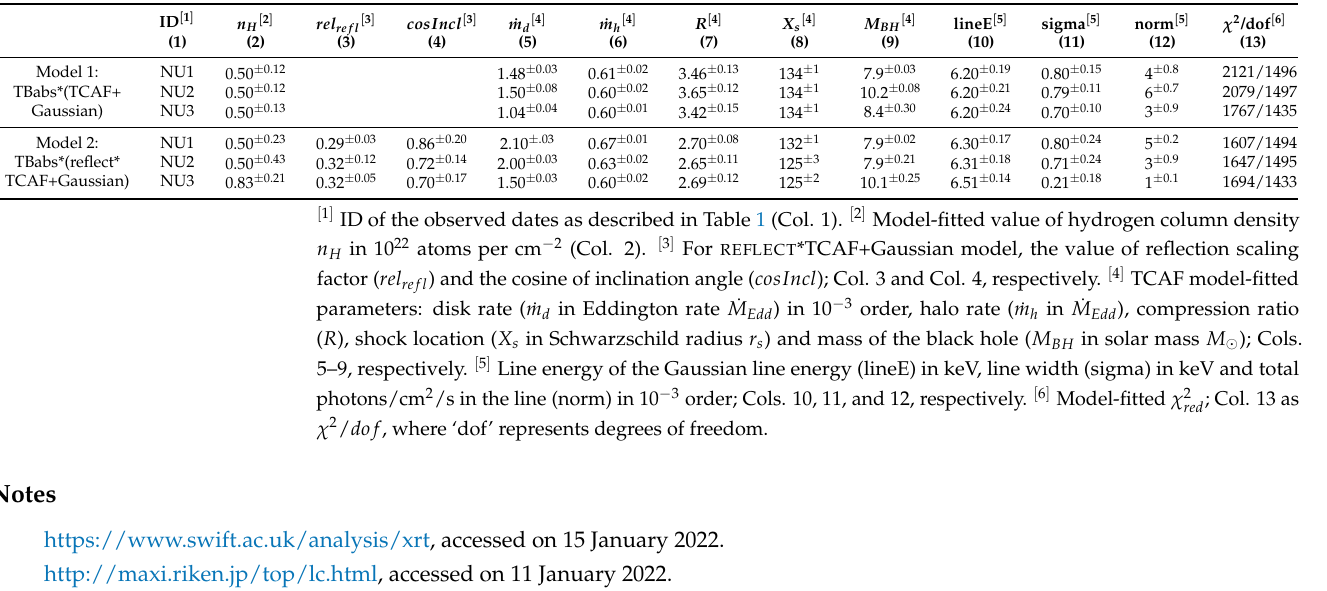
Table A2. Fitted parameters for NuSTAR data with TCAF/ REFLECT *TCAF model along with a Gaussian line (taking mass ( M BH ) as a free